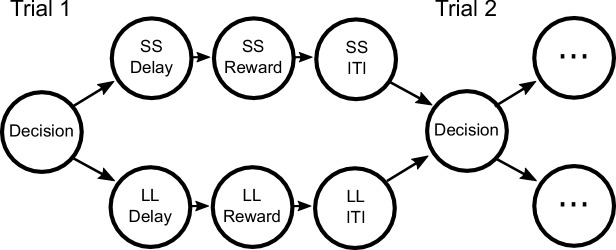
State space diagram of the intertemporal choice task.Decisions made in Decision states cause transition to the Delay, Reward, and ITI states for the option chosen (either SS or LL), then back to the next Decision state. The model consisted of 10 consecutive trials — the number of free choice trials — plus the value of rewards in future games.